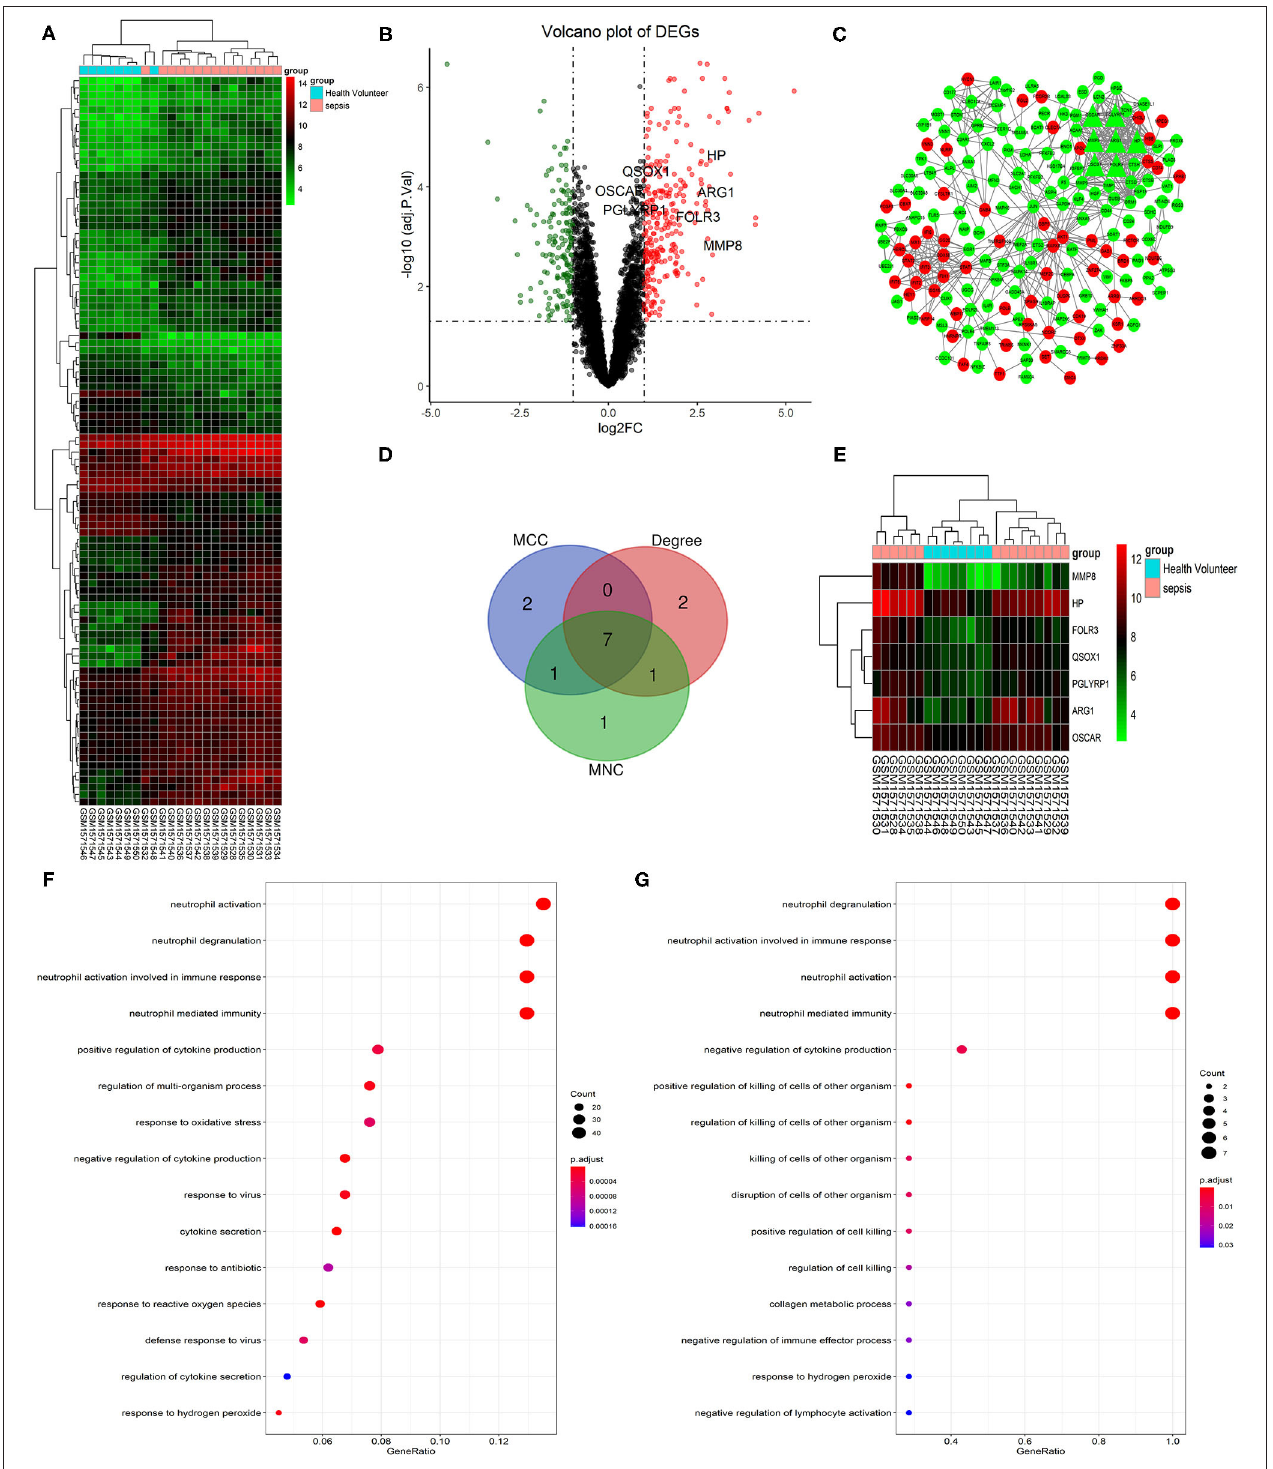
FIGURE 1 | Identification and GO functional analysis of DEGs and hub genes in GSE64457. (A) The top 100 most significant DEGs are shown in the heatmap (|log2FC| > 1 and adj. p < 0.05). Red indicates a high expression, while green indicates a relatively low expression. (B) The volcano plot shows the 429 DEGs that containing 266 upregulated genes in red (log2FC > 1 and adj. p < 0.05) and 163 downregulated genes in green (log2FC < − 1 and adj. p < 0.05). Hub genes are highlighted in the plot. (C) Shows the PPI network of DEGs. Red notes the upregulated genes and green noted the downregulated genes. Triangles represent the hub genes in the network. (D) Hub genes ( MMP8 , HP , ARG1 , FOLR3 , QSOX1 , PGLYRP1 , OSCAR ) were identified by the overlapping of three algorithms (MNC, MCC, and Degree) in the cytoHubba plugin in Cytoscape and clustered in heatmap (E) . The top 15 GO terms are shown in the dot plots of GO functional analysis of